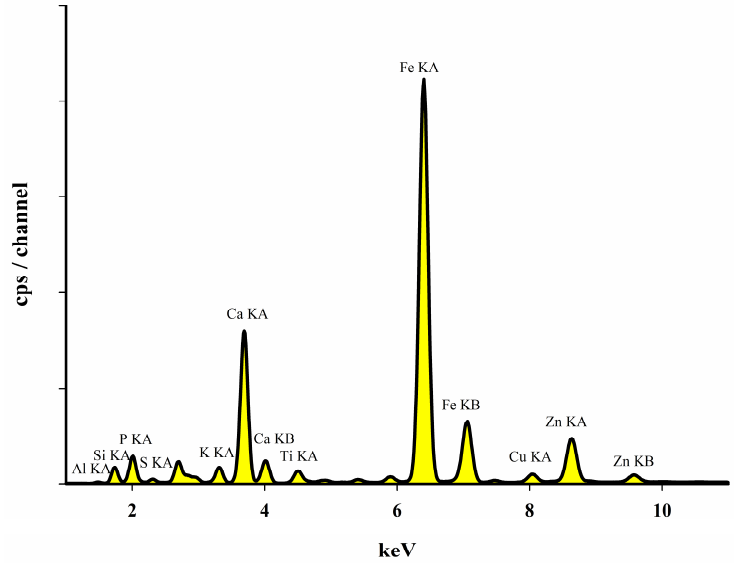
Figure 6. EDXRF spectrum of an example